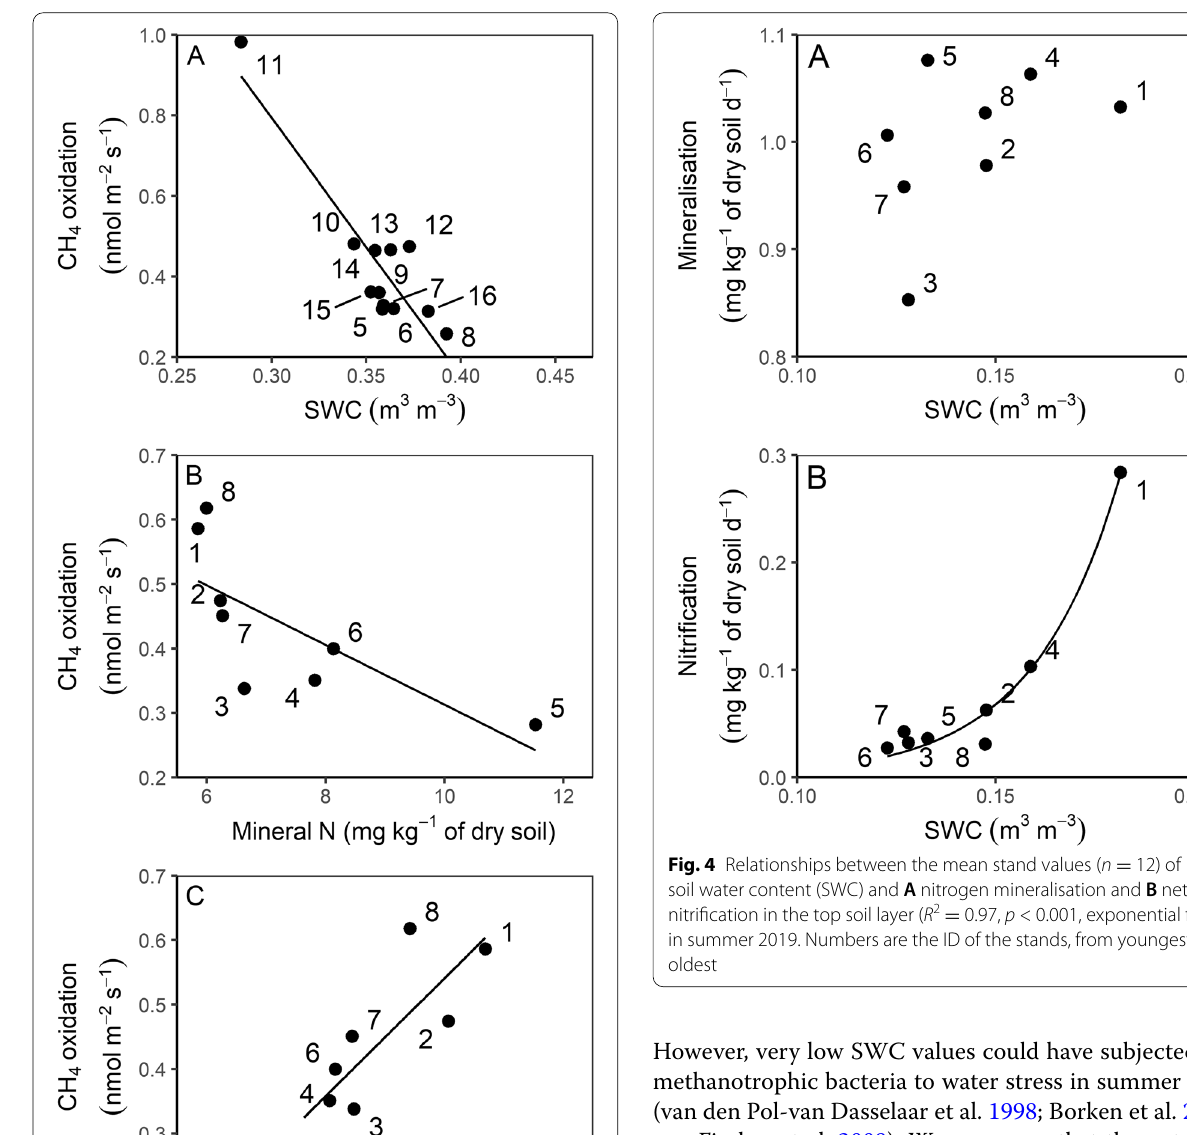
12) of = 0.82, p < 0.001), B = 0.55, p = = 0.68, p 0.012). = =